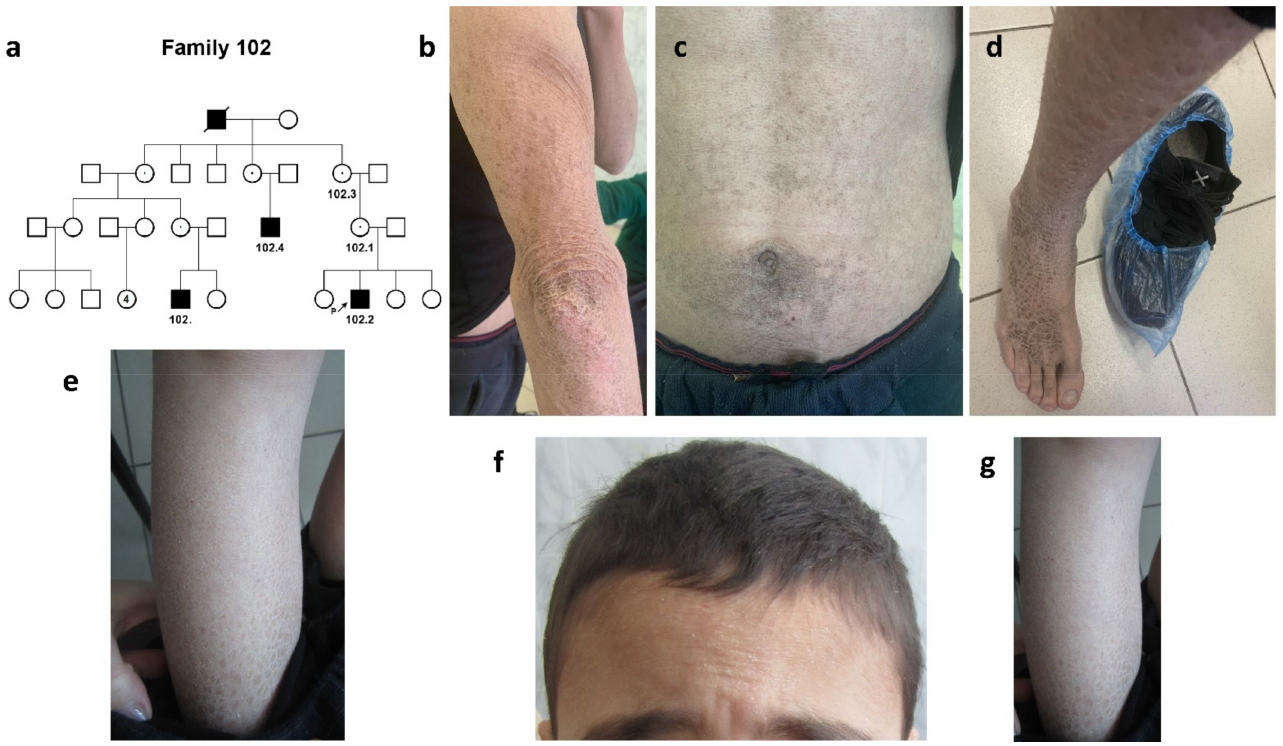
Figure 1. Family #102. ( a ) Pedigree #102. Four-generation pedigree #102 enclosed 8 nuclear families with 4 ichthyosis patients, #102.2, #102, #102.4, and their common great grandfather by their mothers; ( b – d ) photo of patient #102.4. Hyperkeratosis of the skin on the elbows ( b ), abdomen ( c ), dark-brown scaling on the leg and back of the foot ( d ); ( e ) photo of patient #102. Abundant “dirty” brown scales on the legs; ( f , g ) photo of patient #102.2. Dry scales on the forehead and hairy part of the head ( f ) and brown scaling on the legs ( g